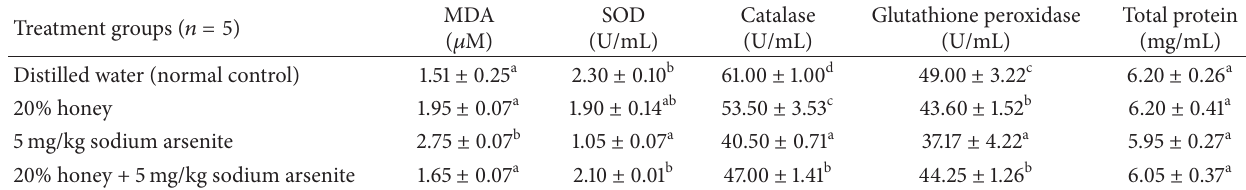
Table 3: Redox sensitive biomarkers level in rat kidney tissues due to Acacia honey and sodium arsenite administration. Treatment groups ( 𝑛 = 5